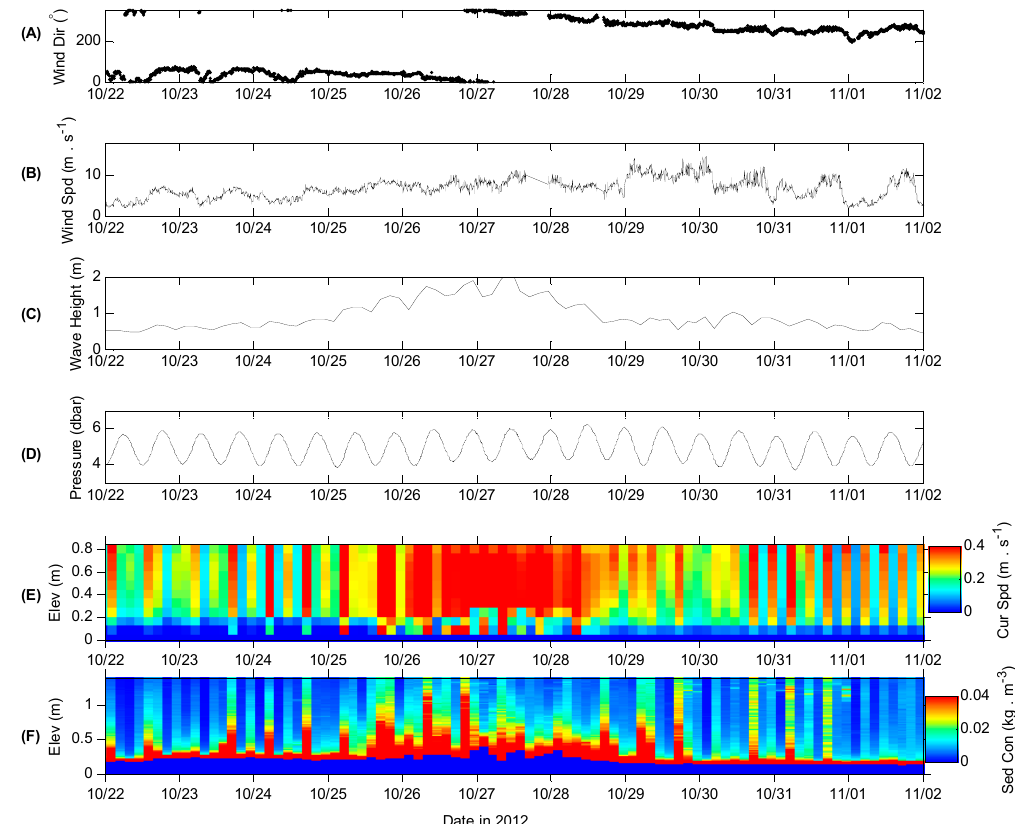
Figure 6. ( A ) Wind direction and ( B ) speed from Fort Pulaski, GA; panels ( C – F ) are data from reference site R1 collected between 22 October and 2 November 2012 during Hurricane Sandy. ( C ) Wave height and ( D ) pressure are based on upward-looking AWAC. ( E ) Current speed is from downward-looking PCADP. ( F ) Suspended sediment concentration is from downward-looking ABS.